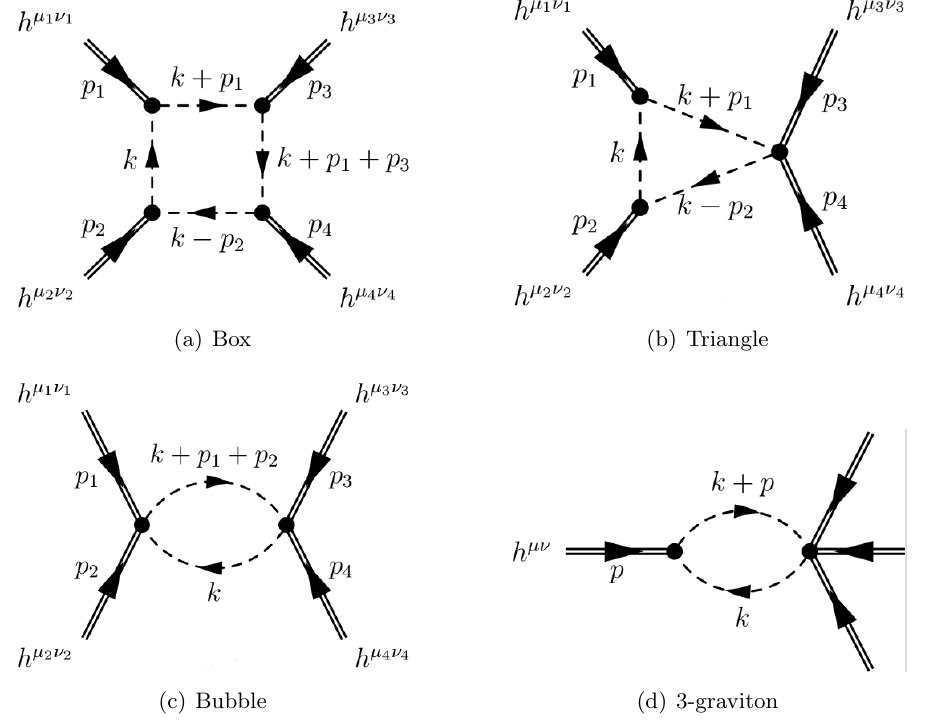
Figure 7 . Feynman diagrams for the pseudo-amplitude in the free scalar